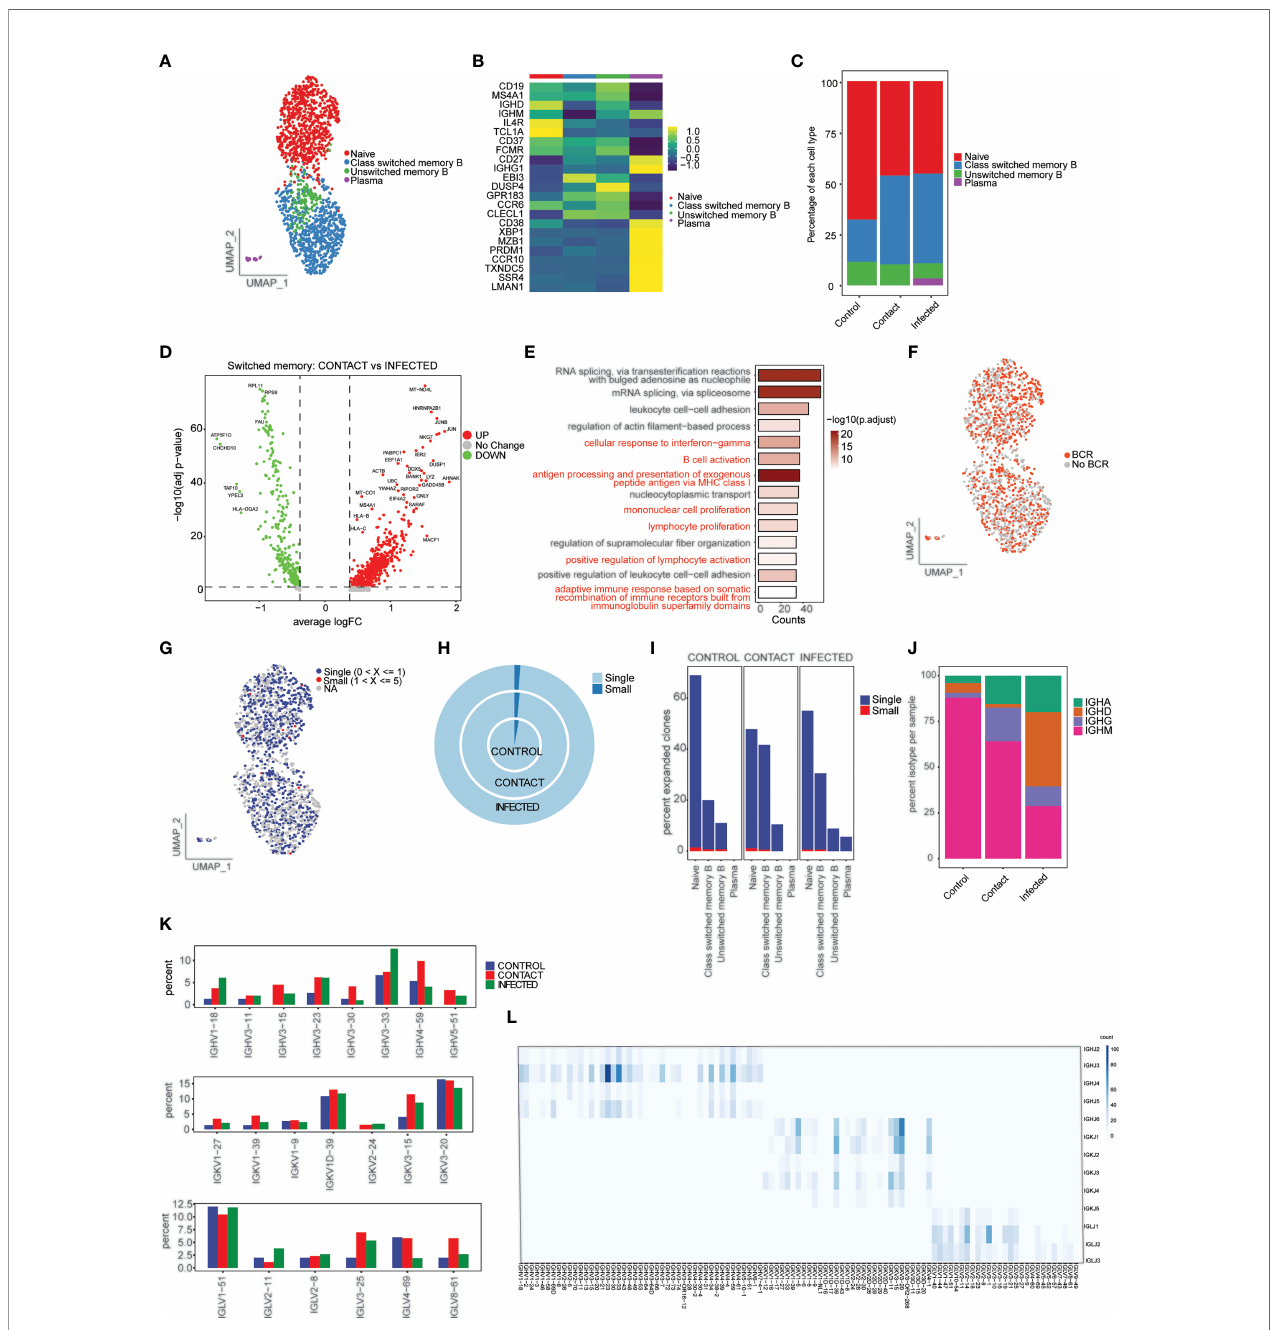
FIGURE 6 | Characterization of B cells and B-cell repertoire. (A) UMAP representation of 1,626 single cells, color coded according to B-cell subtypes. (B) Heatmap showing expression of marker genes for naive B ( CD19 + IGD + CD27 − ), class switched memory B ( CD19 + IGD − CD27 + ), unswitched memory B ( CD19 + IGD + CD27 + ), and plasma ( CD38, XBP1, MZB1 ). (C) Bar plot showing relative contribution of B-cell subtypes in control, contact, and infected patient samples. (D) Volcano plot showing the differentially expressed genes of class switched memory B cells between the contacts and infected patients. p-values were calculated using non- parametric Wilcoxon rank-sum test, and adjusted p-value were calculated based on the Bonferroni correction procedure. (E) GO BP enrichment analysis of differentially expressed genes upregulated in class switched memory B cells in contacts. (F) UMAP representation of B cells colored by BCR detection. (G) UMAP representation of B cells colored by their clonal expansion status. Clones were de fi ned as single (n = 1), small (1 < n ≤ 5). (H) Nested pie plots showing the clonal status across samples. (I) Bar plot showing percentage of expanded clonotypes in each cluster in subject groups. (J) Bar plot showing percentage of IGHA, IGHM, IGHG, and IGHD isotypes in control, contact, and infected patient samples. (K) Bar plot showing usage of some IGH genes (top), IGK genes (middle), and IGL (bottom) genes (L) . Heatmap showing IGH/K/L rearrangement in contact. Colors indicate the frequency of speci fi c gene